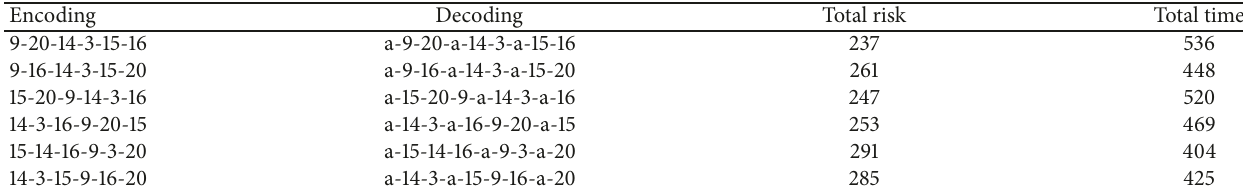
Table 5: Pareto solution set of robust control parameters Γ =0 for distribution center a.